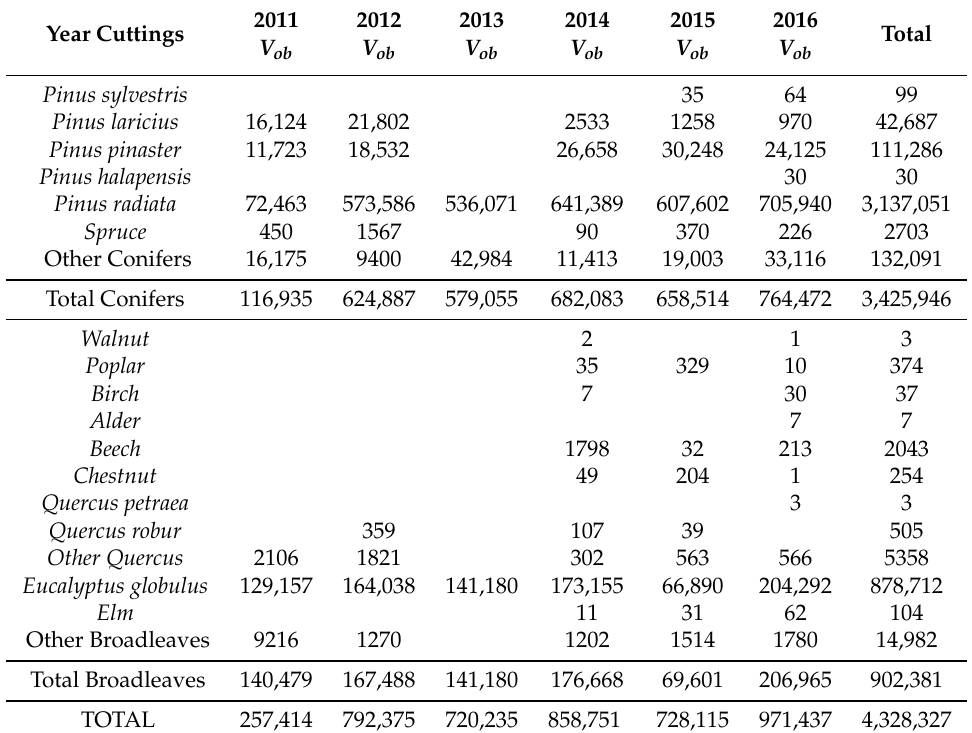
Table 1. Loggings carried out in the forests of Biscay between 2011 and 2016 (Basque government). V ob —wood volume over bark (m 3